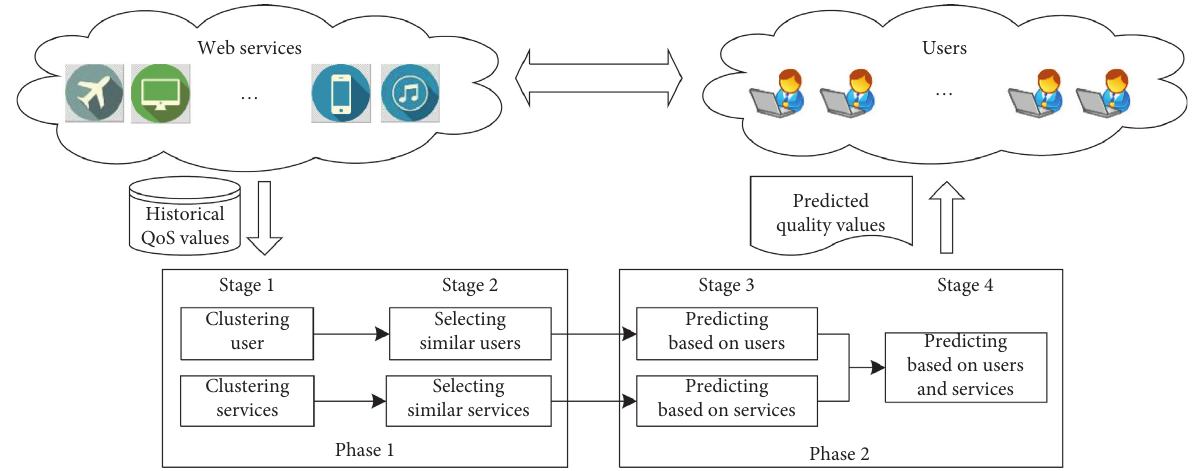
Figure 1: Quality prediction procedure.